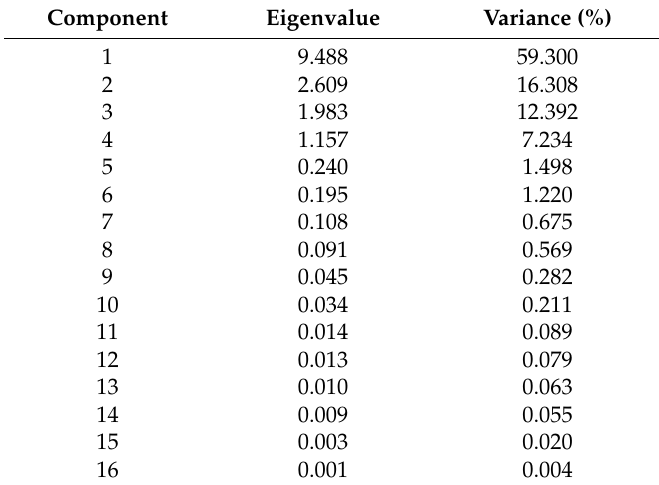
Table 4. Eigenvalues and variance percentage of PCA on 16 texture